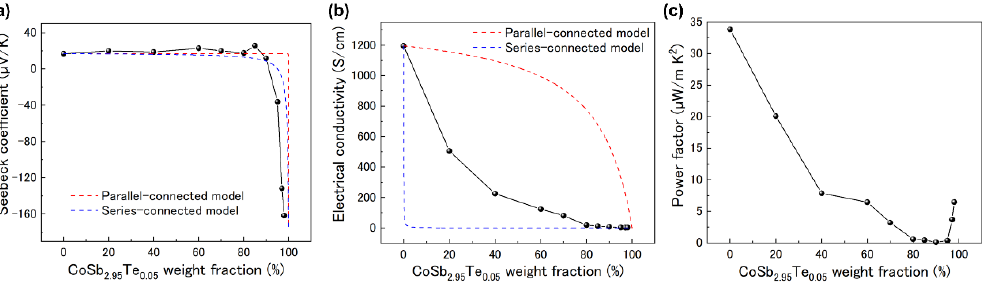
Figure 3. Thermoelectric properties of the hybrid films at room temperature as a function of the weight percentage (0, 20, 40, 60, 70, 80, 85, 90, 95, 97, 98, and 100 wt%) of the CoSb 2.95 Te 0.05 in hybrid films with PEDOT:PSS: ( a ) Seebeck coefficient, ( b ) electrical conductivity, and ( c ) power fac- tor.